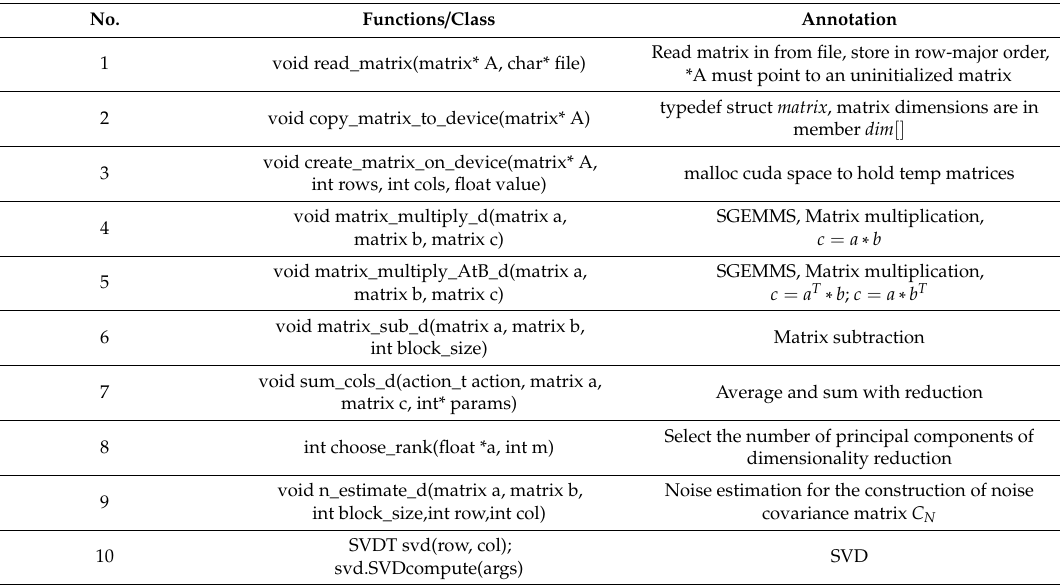
Table 1. Key functions or class and their relative annotation.